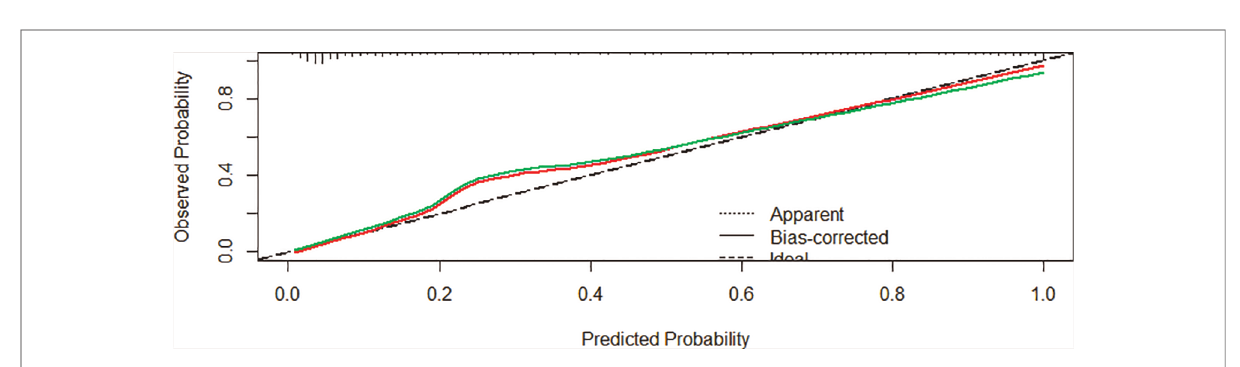
FIGURE 6 Calibration curves of the nomogram model in the validation cohort.